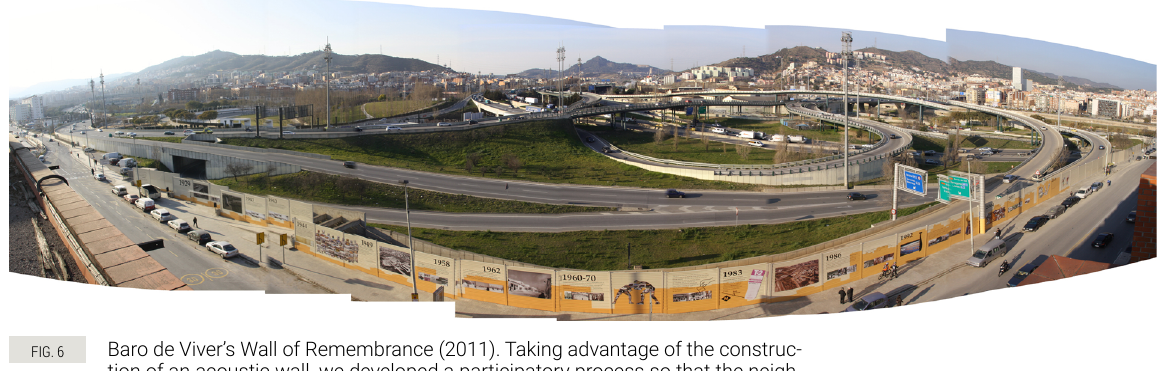
FIG. 6 Baro de Viver’s Wall of Remembrance (2011). Taking advantage of the construc- tion of an acoustic wall, we developed a participatory process so that the neigh- bours could capture their “memory” of the neighbourhood. The mural is 125 m linear x 4 m high and consists of the photographs provided by the neighbours in the participation